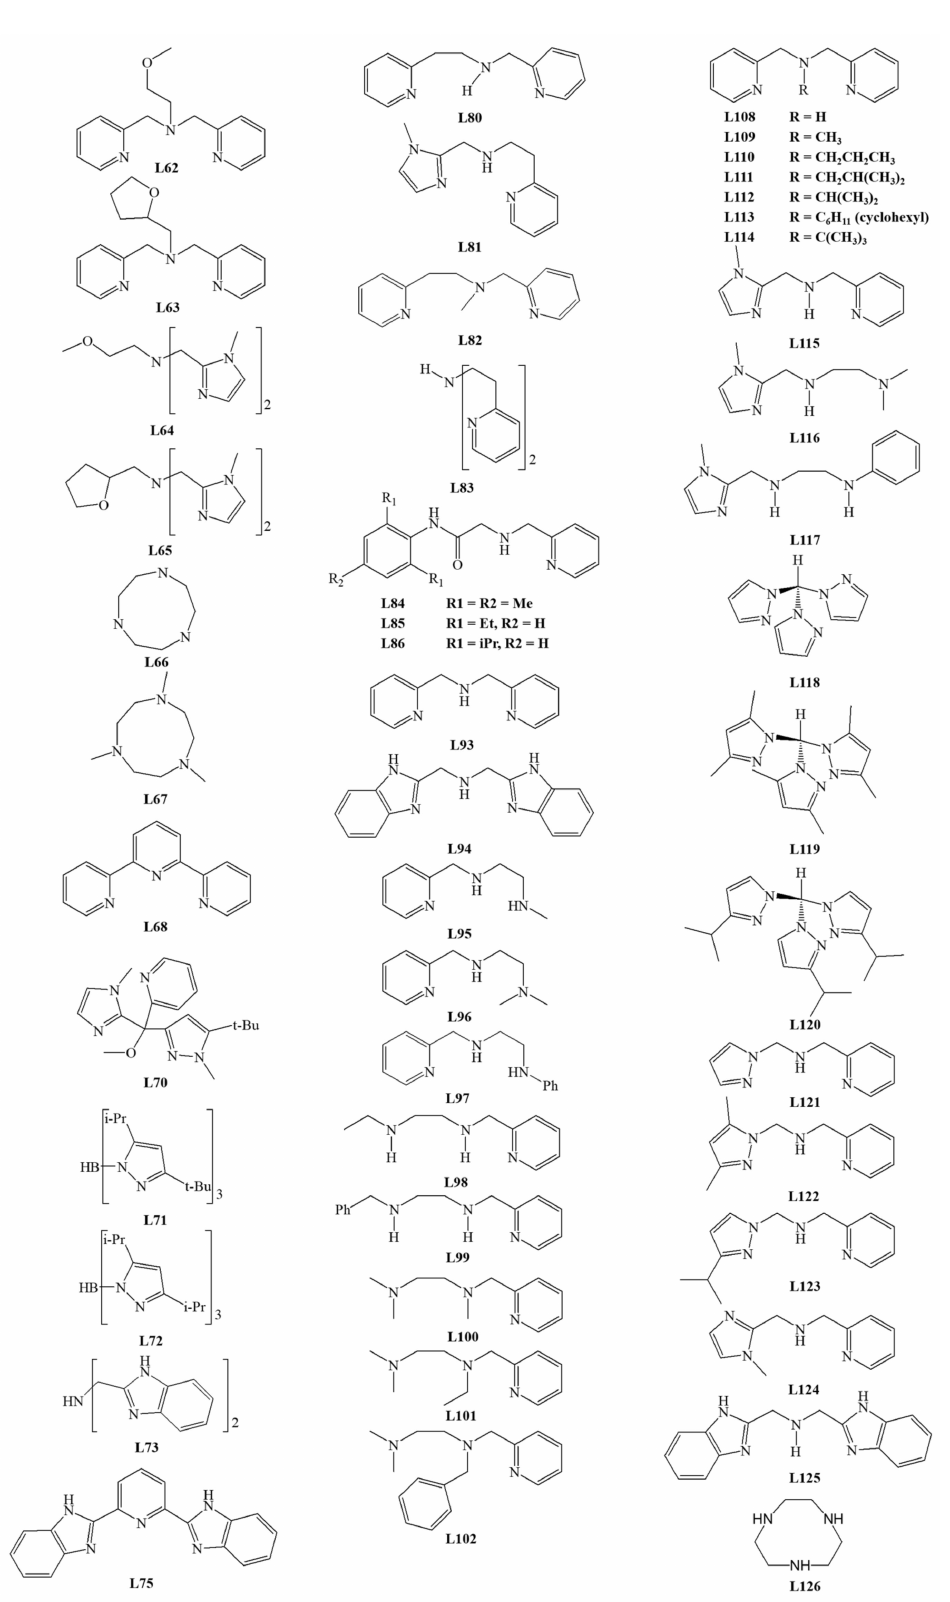
Figure 10. Tridentate N 3